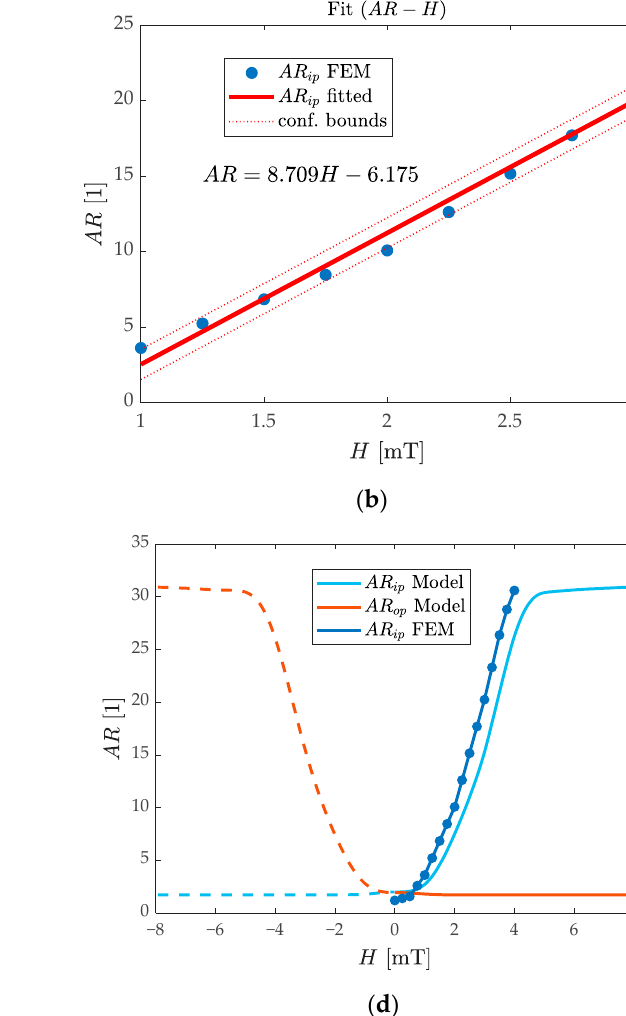
(cid:3009) (cid:3117) (cid:3435)(cid:3037)(cid:3104) (cid:3284)(cid:3291) (cid:3439)